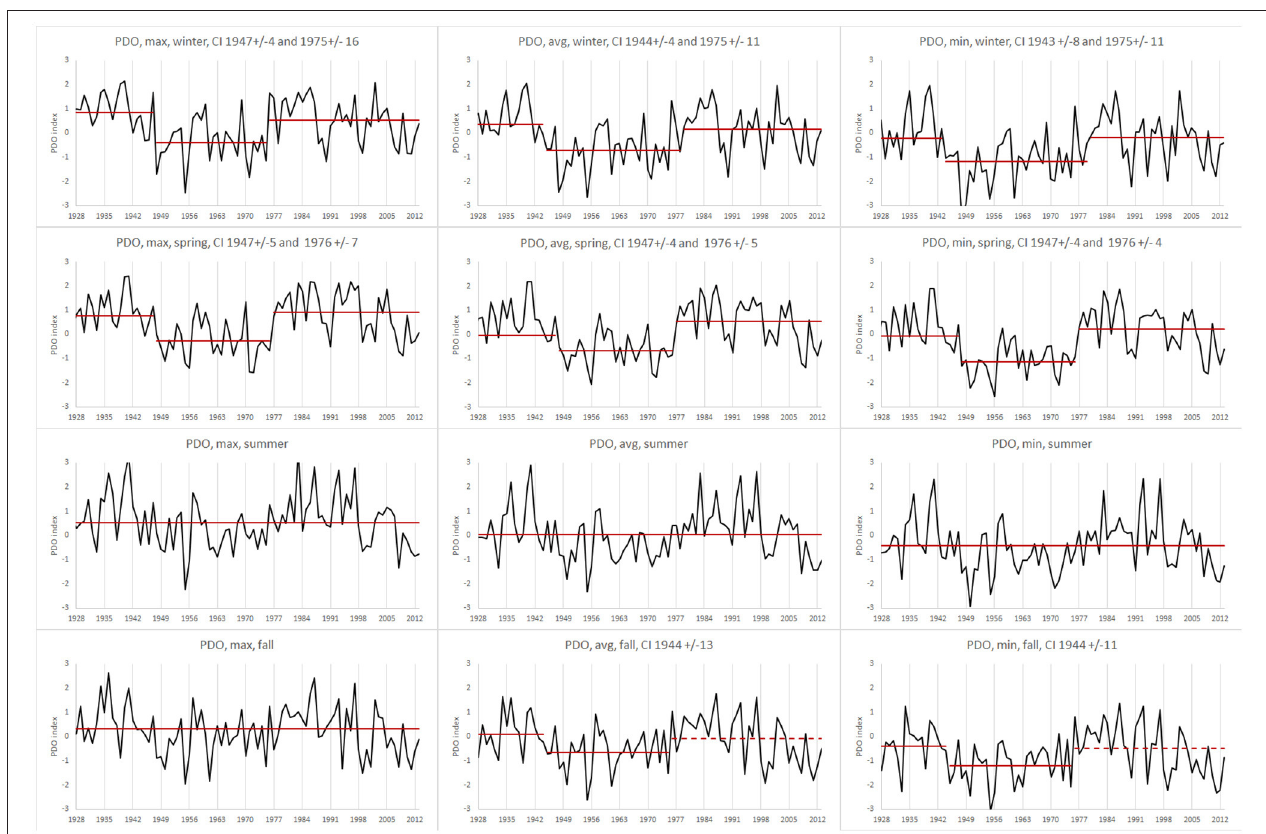
FIGURE 2 | PDO indices for the time-period 1928–2013 for variables maximum, average, and minimum for each of the four seasons together with data means within each segment, where each segment is determined by change-point analysis for PDO indices; solid red lines represent data means within each segment with shifts identified by both the PELT method and the change detection test statistic; dashed red lines indicate data means for segments identified by PELT method but not confirmed by the change detection static when at least one other change is detected by both the PELT method and the change detection